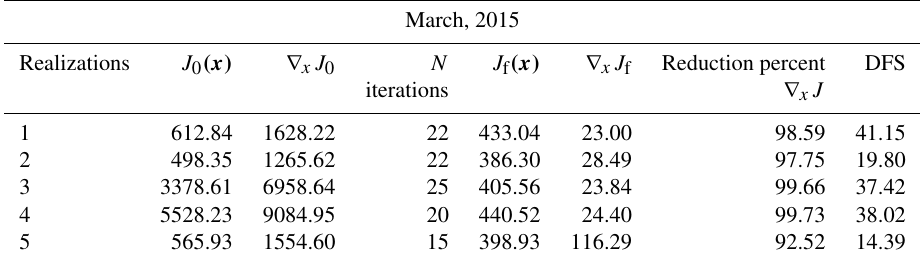
Table C1. Convergence diagnostic of sensitivity case (1) after the inversion using an ensemble of five independent OSSEs for March 2015 ( ∇ x J 0 and ∇ x J 0 represent the initial cost function and its gradient at the beginning of the optimization, and ∇ x J f and ∇ x J f represent them at the end of the optimization).